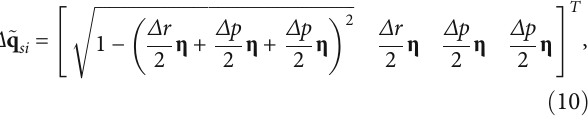
Figure 4: Angles between STR boresight and sun